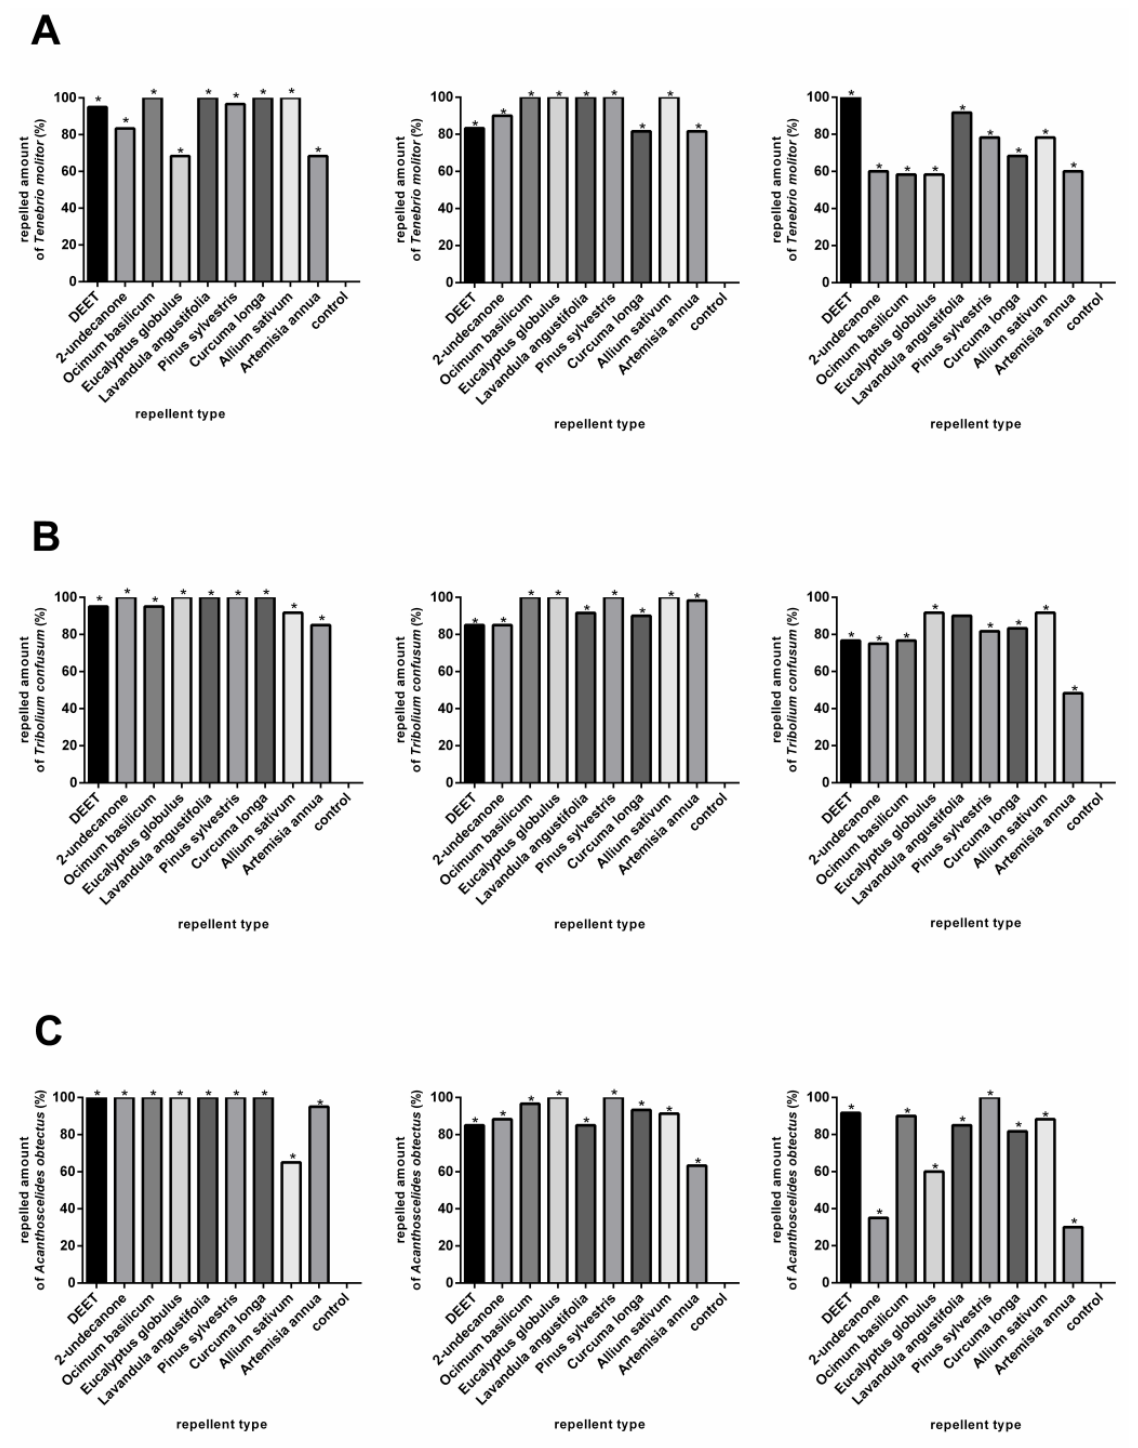
Figure 1. The reactions of Tenebrio molitor ( A ), Tribolium confusum ( B ), and Acanthoscelides obtectus ( C ) to chemical products (DEET and 2-undecanone) and essential oils ( Ocimum basilicum , Eucalyptus globulus, Lavandula angustifolia, Pinus sylvestris, Curcuma oblonga, Alium sativum , and Artemisia annua ) in comparison to control group. Significant differences are marked with an asterisk (*). The order of the graphs determines the concentrations used in the experiments (1%; 0.1% and 0.01%). Means of attracted individuals are pictured.